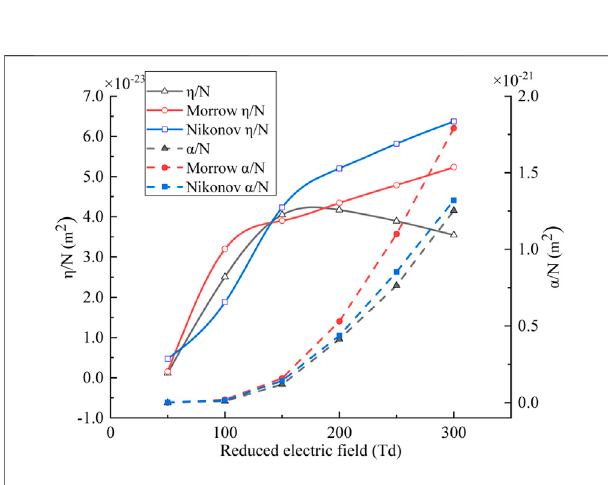
FIGURE 2 | The variation of ionization coef fi cient and attachment coef fi cient with reduced electric fi